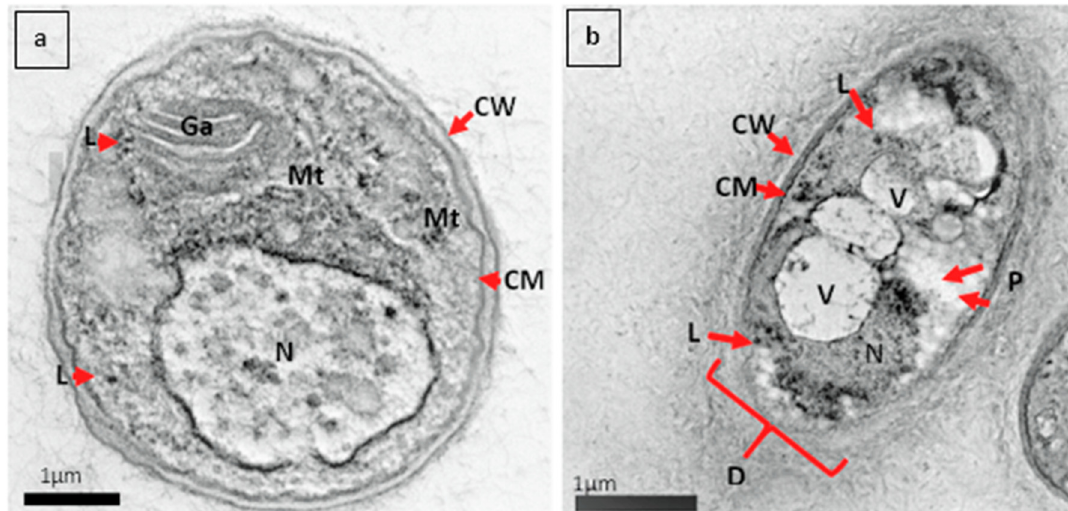
Figure 2. Ultra-structure observed via HR-Transmission electron micrograph of G. boninense mycelia ( a ) intact cell wall and cell membrane in healthy mycelium (1 µ m). ( b ) Mycelium excised from benzoic acid (5 mM) incorporated media showing disintegrated cell wall and cell membrane (arrow), thinning of the cell membrane (arrow), and damage in the nucleus (1 μ m). Where, CW: cell wall; CM: cell membrane; Ga: Golgi apparatus; Mt: Mitochondria; N: nucleus; V: vacuole; L: Lipid bodies; P: Polysaccharide inclusions and D: damaged cell wall and cell membrane.